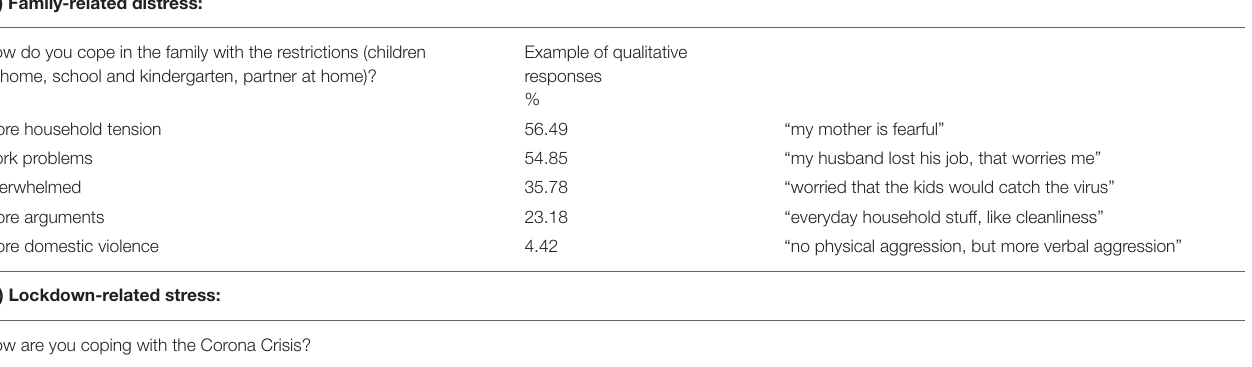
TABLE 2 | Responses to the survey questions grouped into three themes from left to right: family related stress, lockdown related stress, and ability to cope with restrictions. (A) Family-related